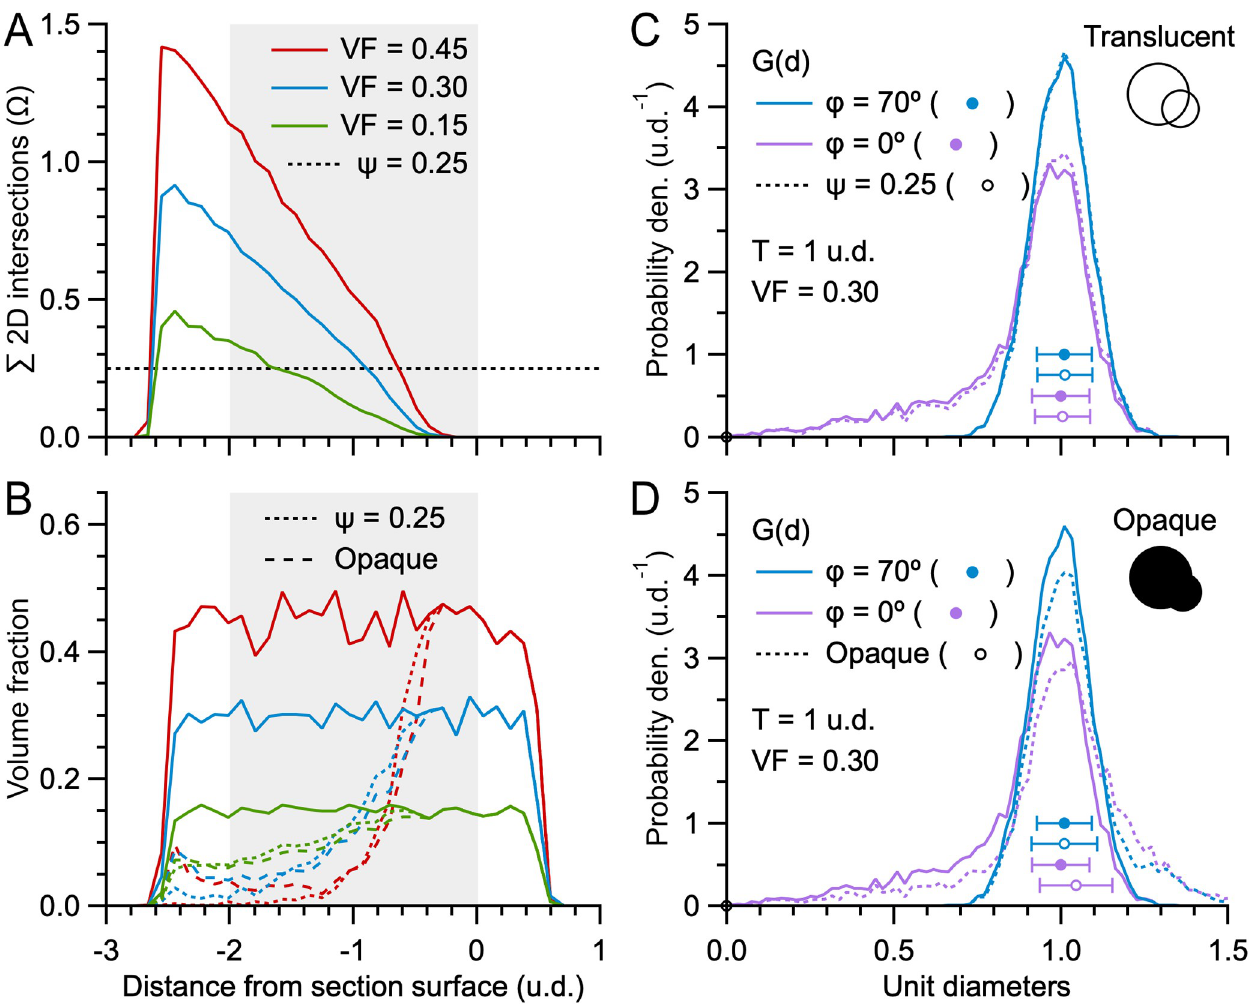
Fig 5. Effects of projection overlaps for thick sections. A. Sum of 2D projection overlaps ( O ) as a function of distance from the surface of a simulated section for particle VF = 0.15, 0.30 and 0.45 (green, blue and red lines) where O > 1 indicates a particle’s projection is likely to be completely overlapping with projections of other particles closer to the section surface. Histograms were computed using particle z-center points and 0.1 u.d. bins. Gray background denotes section thickness (T = 2 u.d.). The distributions extend 0.5 u.d. below the section because of caps (Fig 1B). Black dotted line denotes upper limit ψ = 0.25 for B and C . For simplicity, ϕ = 0˚. B. VF of those particles appearing in a simulated projection as a function of distance from the surface of each section (T = 2 u.d.) for transparent particles (solid lines; control, ψ = 1 ), semi-transparent particles (dotted lines; a particle is removed from the projection if its O > 0.25) and opaque particles (dashed lines; bottom-dwelling particles are merged with top-dwelling particles if -1 < α < 0; Materials and Methods). VF = 0.15, 0.30 and 0.45 as in A . The effect of semi-transparent and opaque particles is to reduce the effective T. Histograms were computed using particle z-center points and 0.1 u.d. bins; counts were converted to VF using the equivalent bin volume (geometry Area xy multiplied by bin z-width) and particle diameter distribution. For simplicity, ϕ = 0˚. C. Comparison of simulated probability density of 2D diameters (G(d); 0.02 u.d. bins) for transparent and semi-transparent particles ( ψ = 1 and 0.25; solid vs. dotted lines) shows little difference for two extreme conditions of lost caps ( ϕ = 0˚ and 70˚; purple and blue). In these simulations, projection overlaps did not affect estimates of their size (inset). Circles and error bars denote Keiding-model fit parameters μ D ± σ D . T = 1 and VF = 0.30. D. Comparison of simulated G(d) for transparent and opaque particles (solid vs. dotted lines). For opaque particles, overlapping projections with -1 < α < 0 were treated as a single projection with larger area (inset), thereby creating a positive skew in G(d). For A – D , average histograms were computed from 20 sections, ~500 particles per